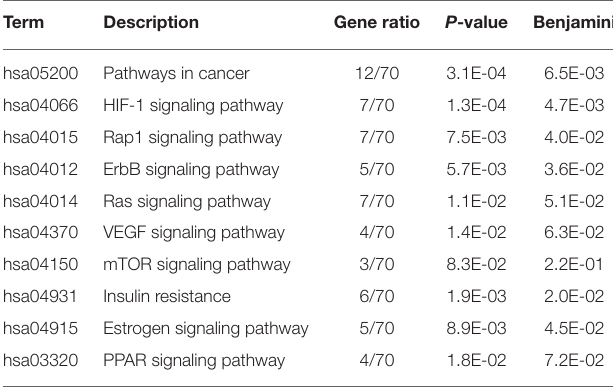
TABLE 3 | KEGG pathway enrichment analysis.